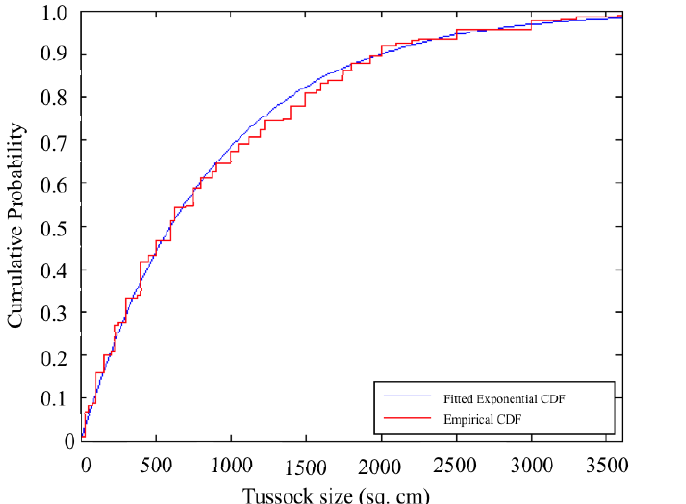
Figure 2. Cumulative probability plot of the bestfit distribution (Exponential)